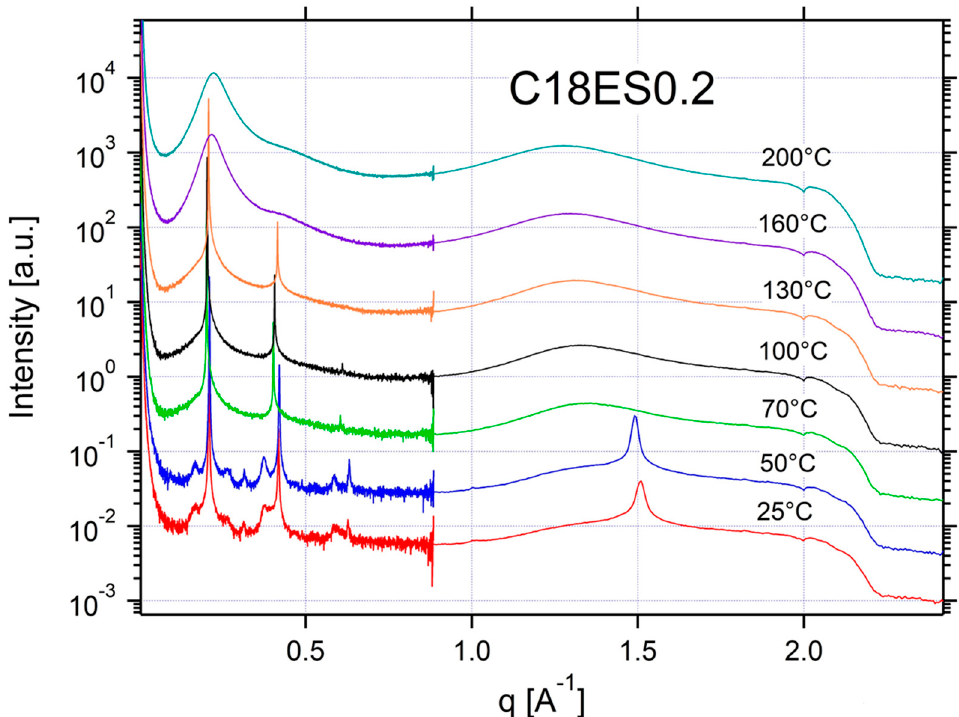
Figure A18. SAXS and WAXS data for 0.2:1 C18ES:C18LiTFSI.